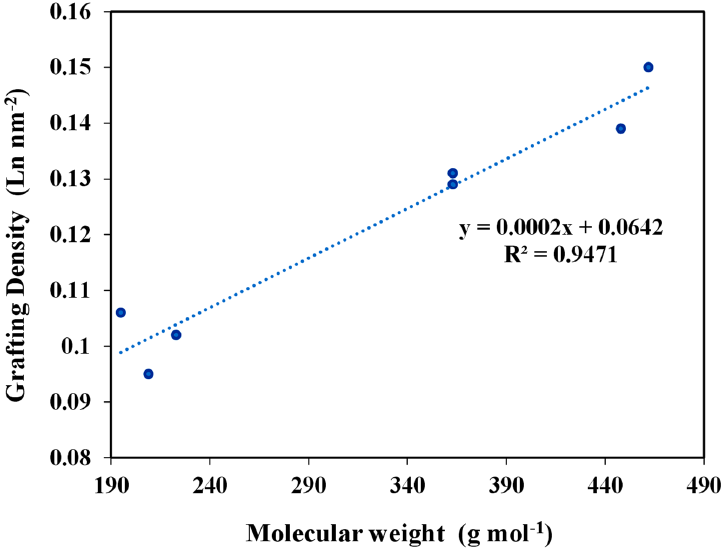
Figure 4. Variation of Grafting Density as a function of Molecular Weight of